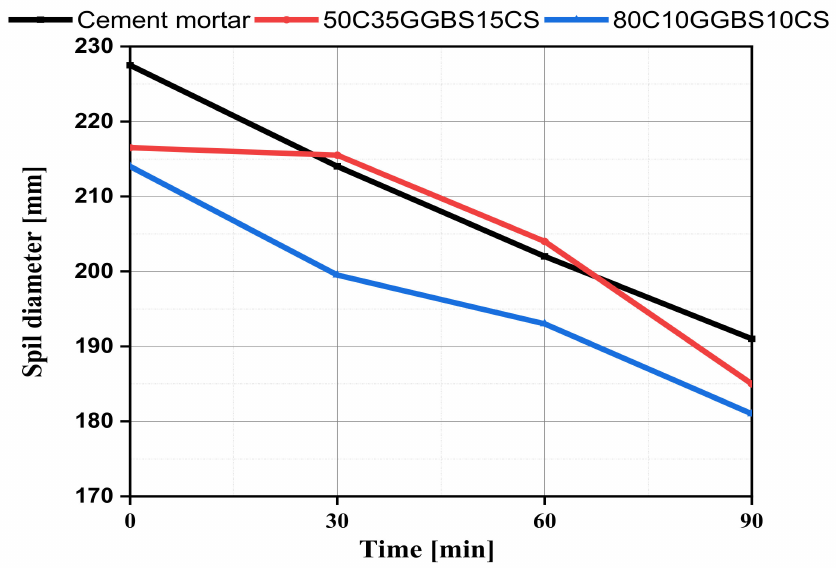
Figure 9. Evolution of flow value as a function of